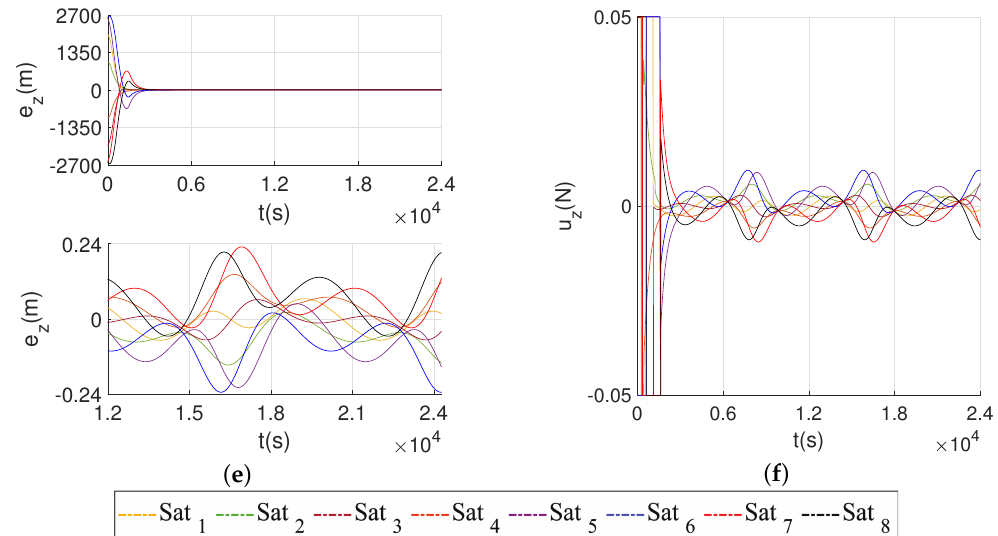
Figure 12. PB law. Error and control time histories: ( a ) errors along axis x; ( b ) controls along axis x;